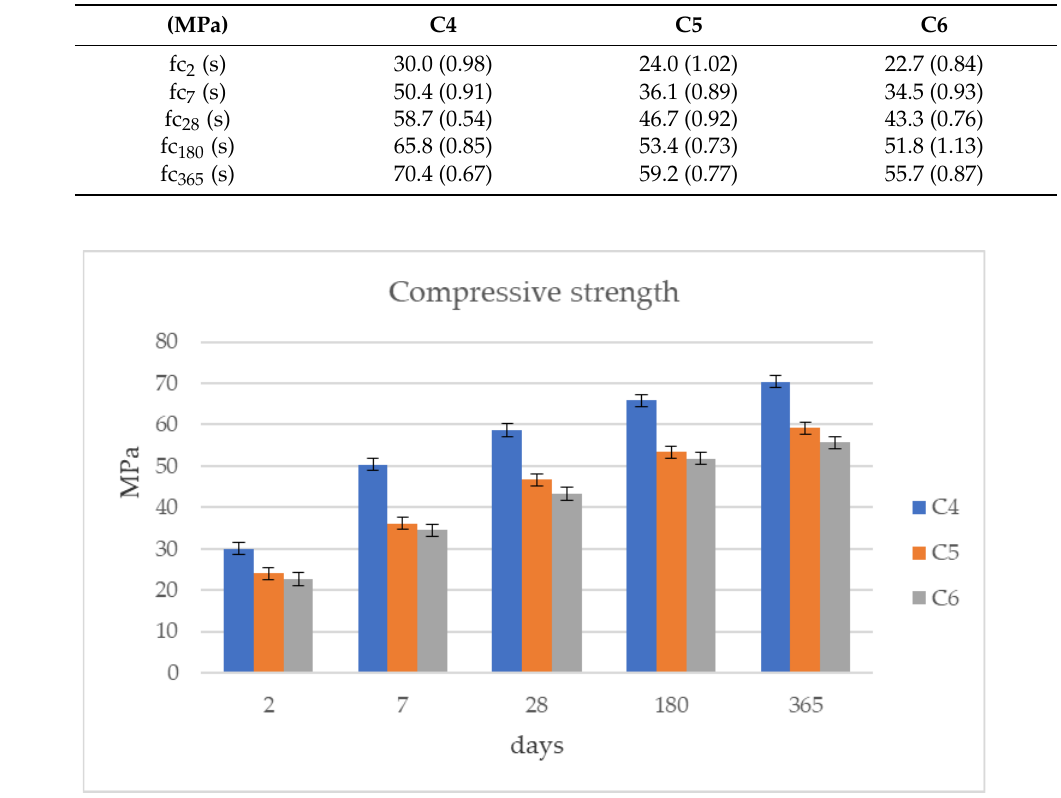
Figure 6. Compressive strength (MPa) of C30/37 strength class